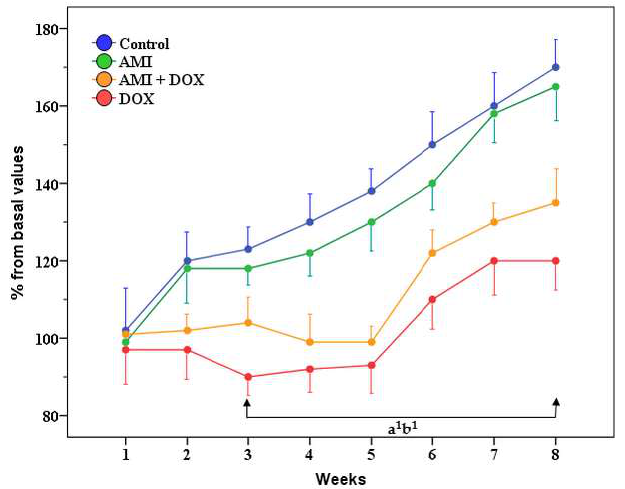
Figure 1. The influence of amifostine (AMI) and/or doxorubicin (DOX) on the body weight of rats during the 8 weeks of the study. The results are expressed as a percentage from the control group. a 1 — p < 0.05 for DOX compared with the control group; b 1 — p < 0.05 for AMI + DOX compared with the control group.